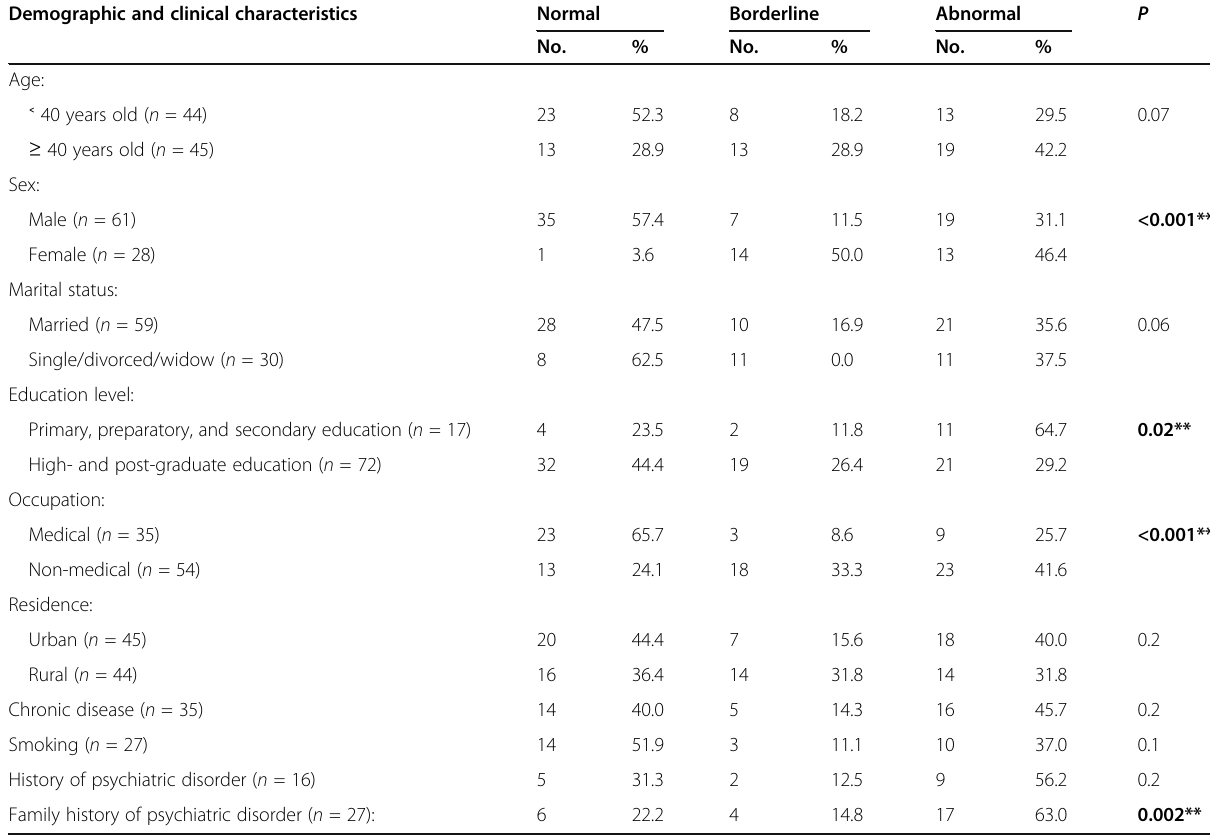
Table 3 Association between HADS – Anxiety and demographic and clinical characteristics of the studied patients Demographic and clinical characteristics